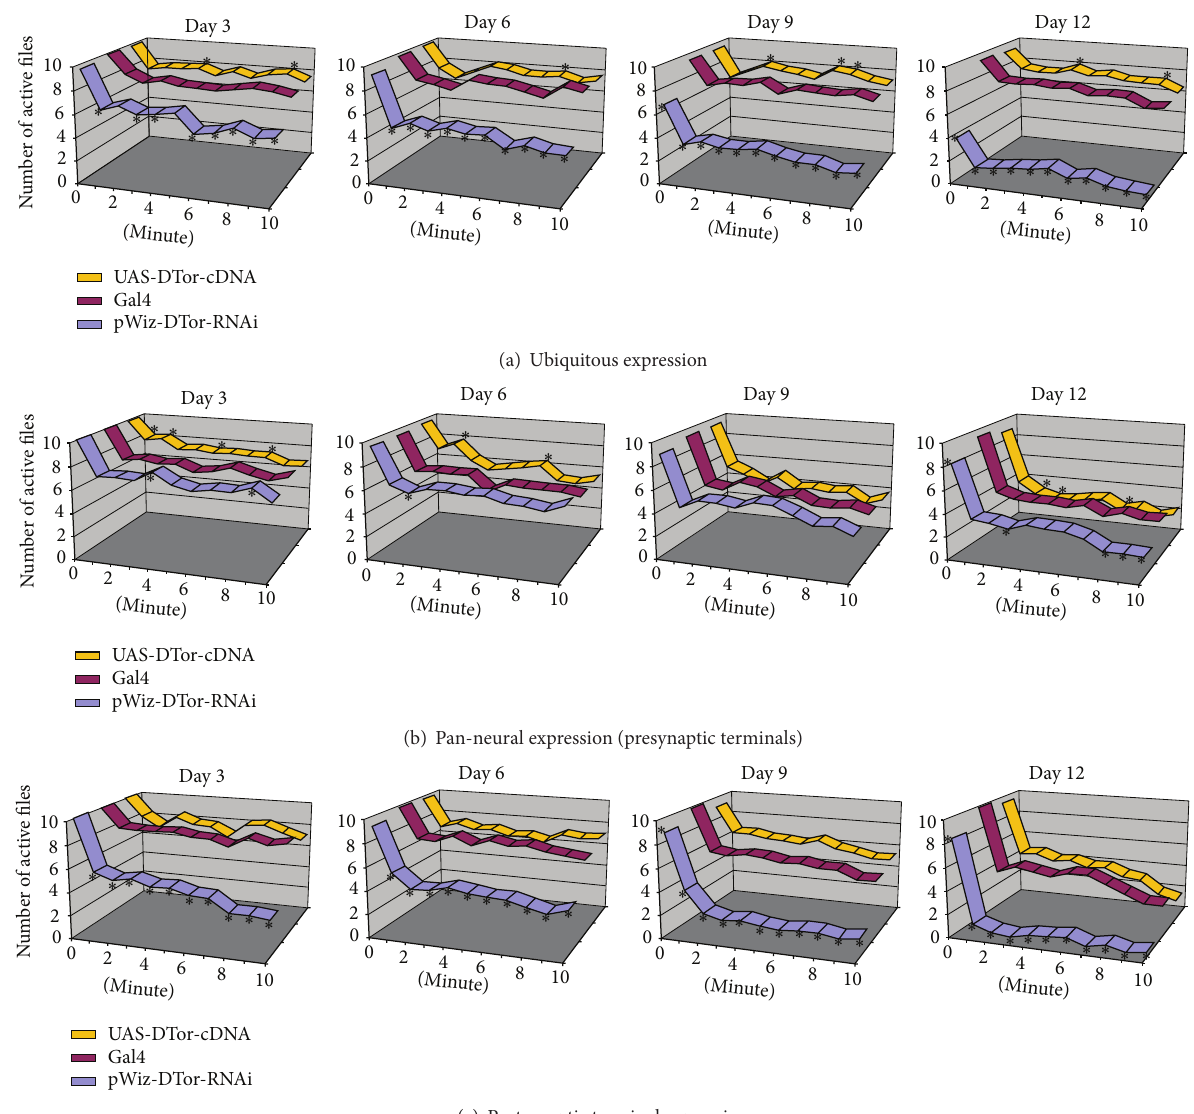
Figure 4: Reduced expression of DTor impaired locomotor behavior. Flies of different ages expressing DTor-cDNA or DTor-RNAi under control of various Gal4 drivers were monitored in vials at 38 ∘ C for 10min. The number of active flies was plotted at each time point. Asterisks indicate the time points showing a significant difference ( 𝑝 < 0.05 ) from 𝑡 -test analysis. (a) Tub-Gal4 drivers, (b) C155-Gal4 drivers, and (c) C57-Gal4 drivers. Ten to twelve groups of Tub-Gal4/+, UAS-DTor-cDNA/+; Tub-Gal4/+, pWIZ-DTor-RNAi/+; Tub-Gal4/, C155-Gal4, C155-Gal4; UAS-DTor-cDNA/+, C155-Gal4; pWIZ-DTor-RNAi/+, C57-Gal4/+, UAS-DTor-cDNA/+; C57-Gal4/+, and pWIZ-DTor-RNAi/+; C57-Gal4/+ were collected from three independent crosses and